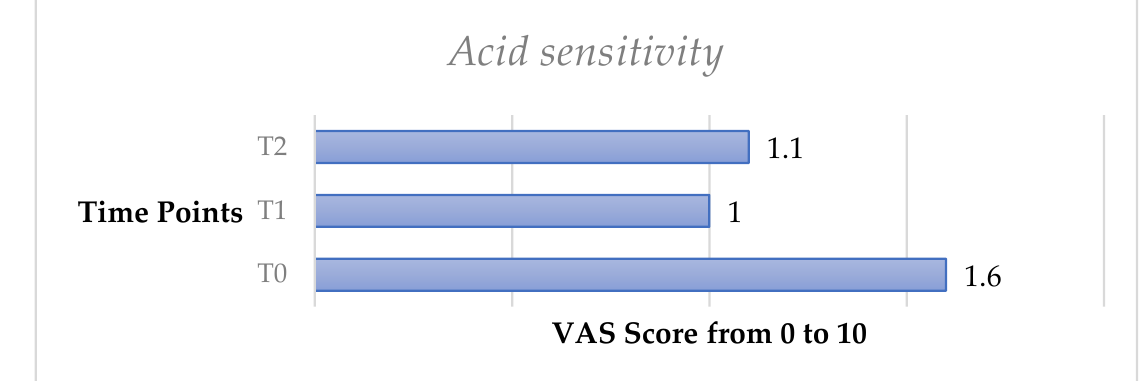
Figure 7. Mean values of acid sensitivity test trend from T0 to T2 in the whole sample.